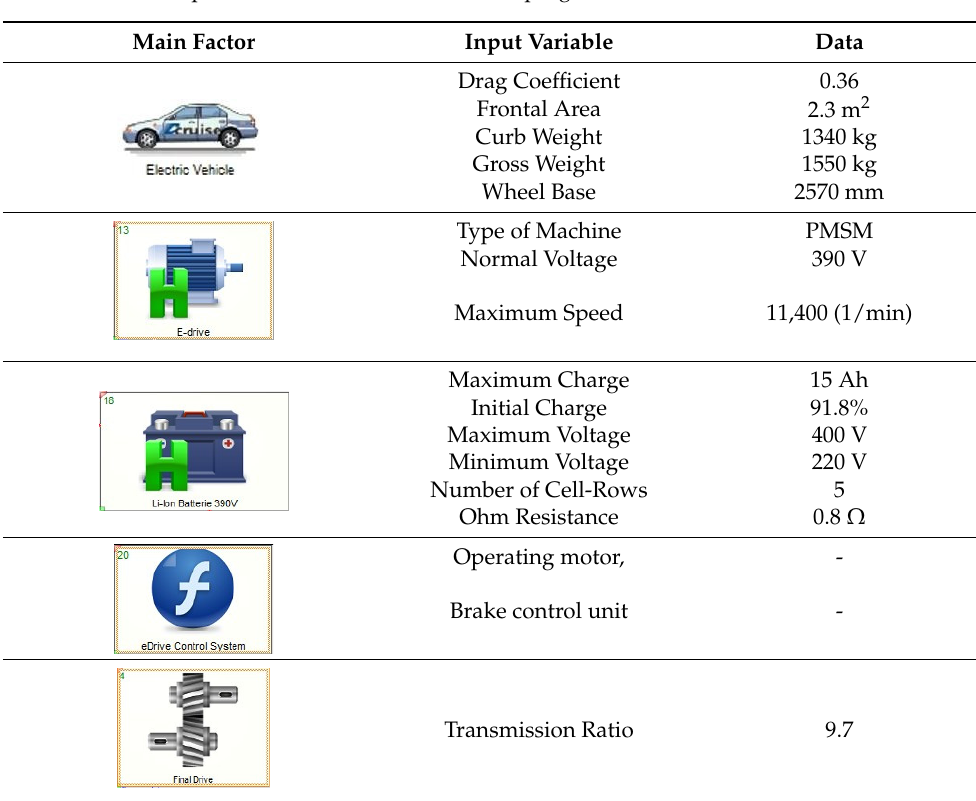
Table 2. EV model parameters used in AVL CRUISE program.